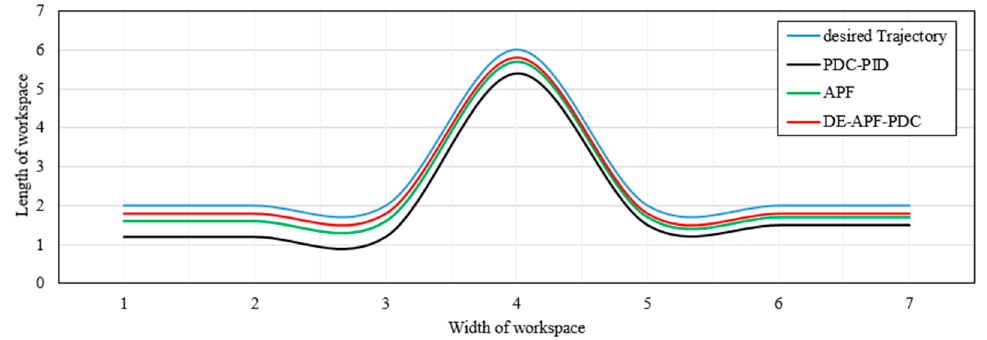
Figure 14. Trajectory of UR5 manipulator.